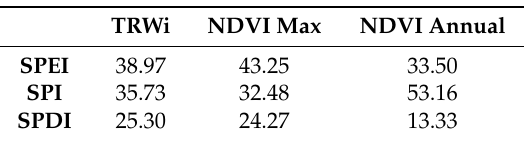
Figure 2. Box plots showing the Pearson correlation coefficients computed between the seven drought indices and ring-width indices, including ( a ) TRWi, ( b ) NDVI max, and ( c ) NDVI annual. The solid black line corresponds to the median, the white asterisks denote the mean and dashed lines show the significant level at p < 0.05 (light pink) and p < 0.01 (dark pink). Table 2. Percentage of the sampled forest stands, with the maximum Pearson correlation coefficients found for each forest variable and with each drought index.